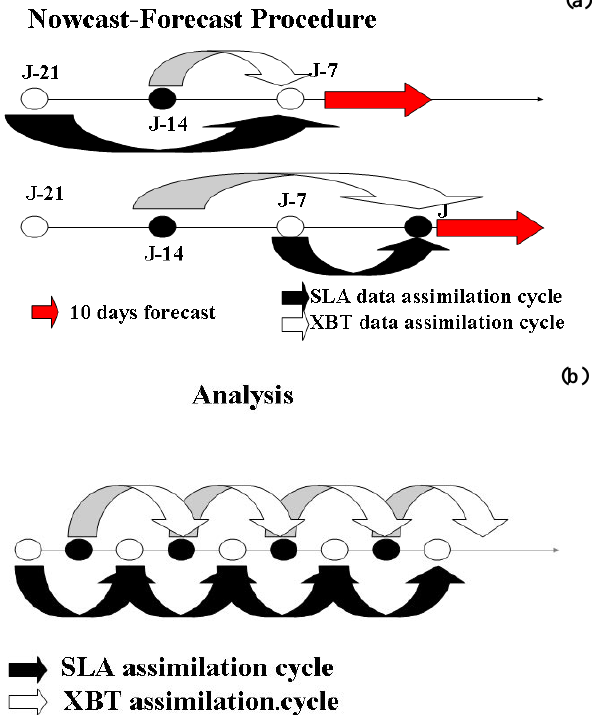
Fig. 4. The scheme of sequential assimilation of SLA and XBT data (a) in the nowcast-forecast procedure and (b) in the analysis.